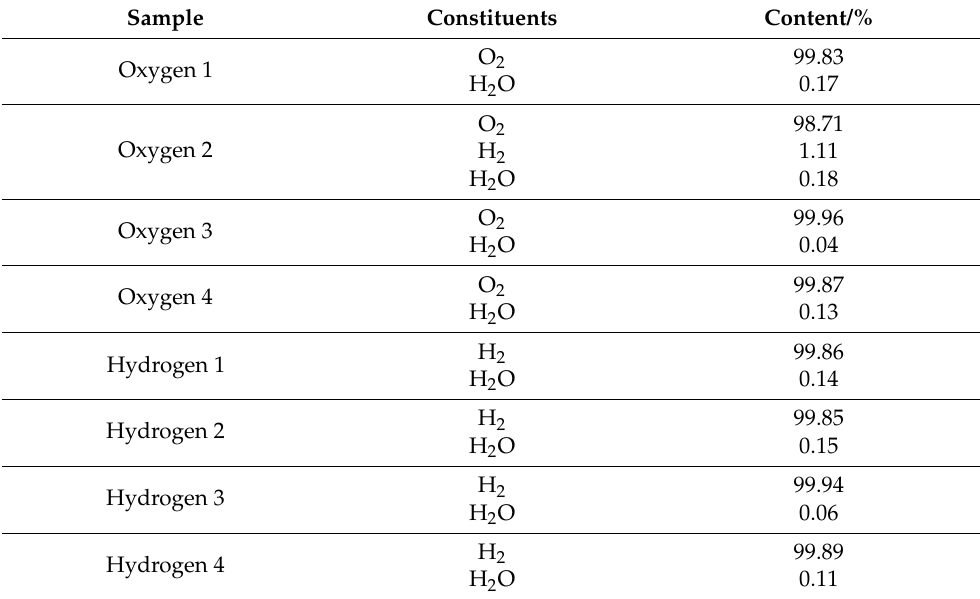
Table 4. Chromatographic analysis of hydrogen and oxygen gas samples generated by means of 500 W AWE stack.